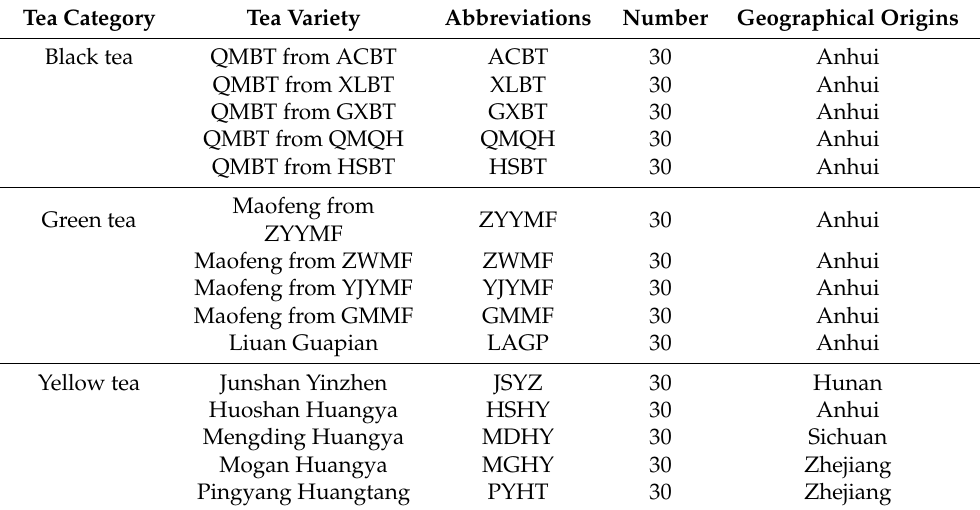
Table 1. Geographical sources of tea.